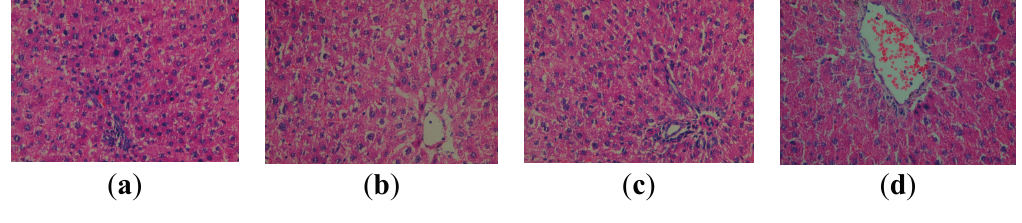
Figure 2. Histopathological evaluation of the liver tissue for group IV (CCl ( a ) Inflammatory infiltrates (HEx400); ( b ) Intralobular cytolysis (HEx400); ( c ) Apoptotic cells, Kupffer cell hyperplasia (HEx400); ( d ) Centrilobular stasis